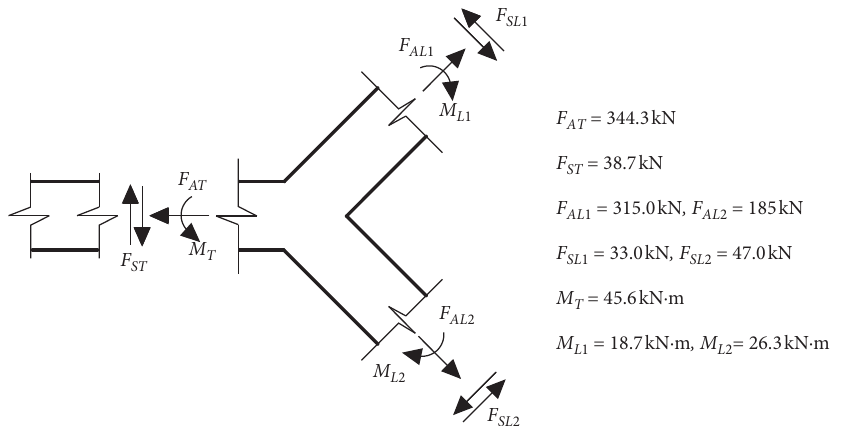
Figure 30: Force diagram of Y-shaped connection.